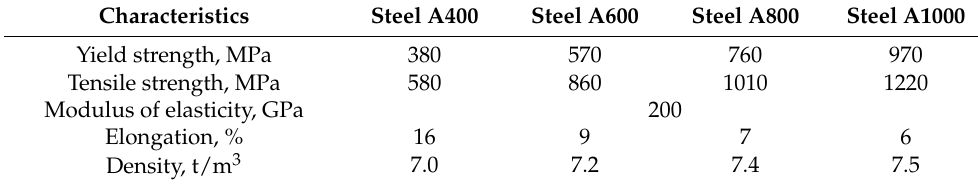
Table 6. Characteristics of the steel reinforcement.